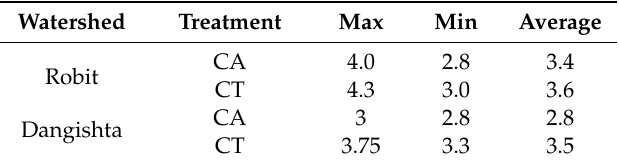
Table 3. Maximum, minimum, and average crop evapotranspiration ( ET c ) in mm/day for Robit and Dangishta watersheds.